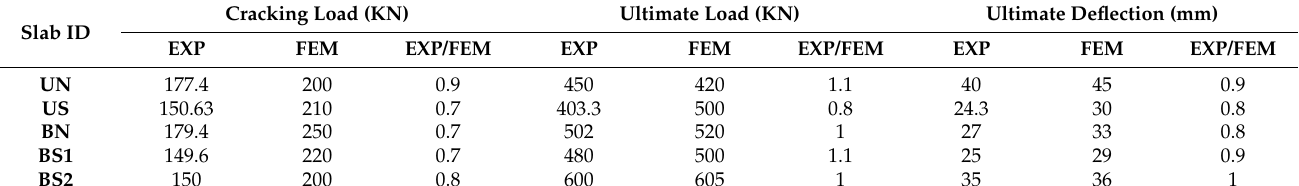
Table 4. Experimental and FEM of cracking load, ultimate load, and ultimate deflection.